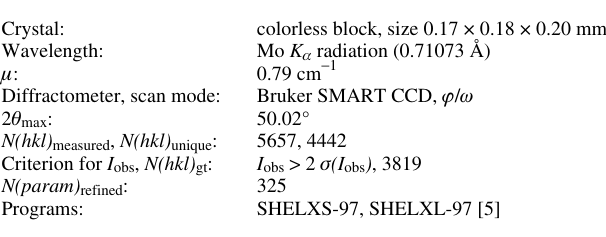
Table 1. Data collection and handling.